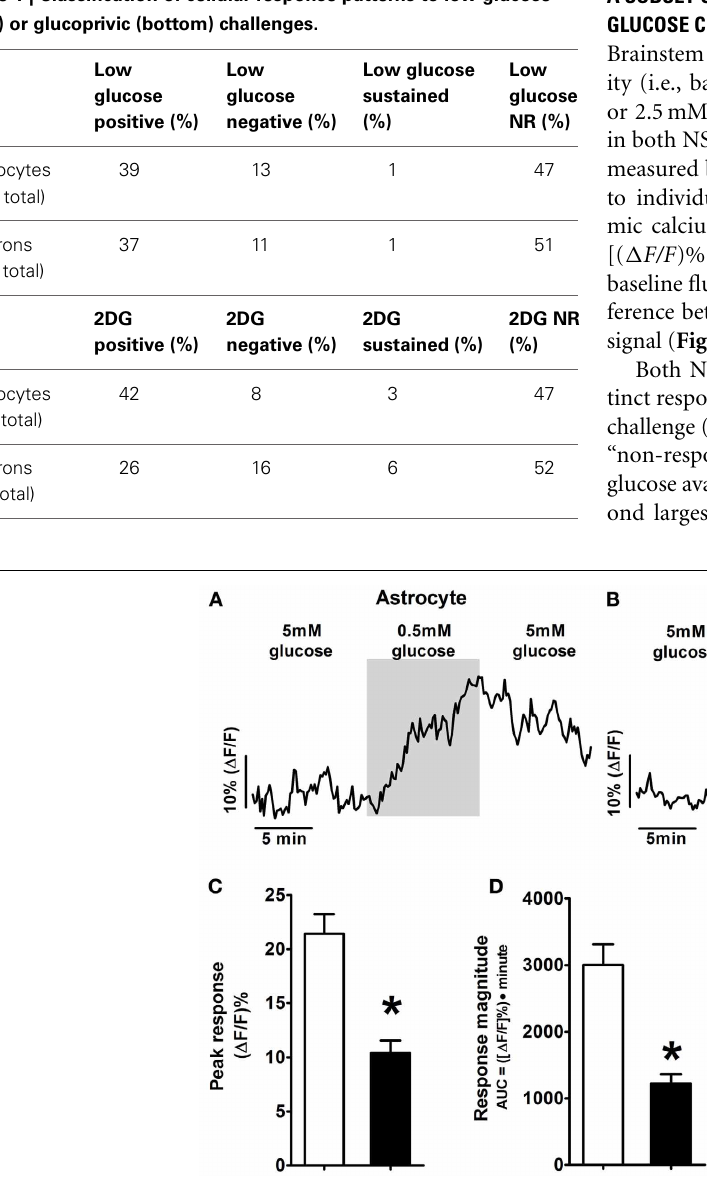
FIGURE 2 | Example of response patterns of low glucose-positive astrocytes and neurons in the hindbrain slice preparation to low glucose challenge. As seen in Figure 1 , mixed fields of NST-astrocytes and neurons were recorded using confocal live cell calcium imaging. Changes in intracellular calcium levels were reflected as changes in intensity of the fluorescent calcium indicator dye, Calcium Green 1-AM. Both low glucose-positive (A) astrocytes and (B) neurons were activated in response to a change in the extracellular glucose concentration from 5 to 0.5mM; this activation returned toward baseline levels following return to 5mM glucose. [Traces in (A,B) are the average response of five representative low glucose positive astrocytes and neurons,